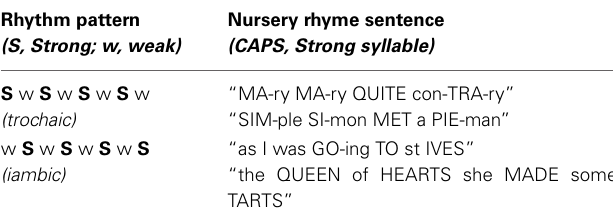
Table 2 | List of nursery rhyme sentences and their rhythm